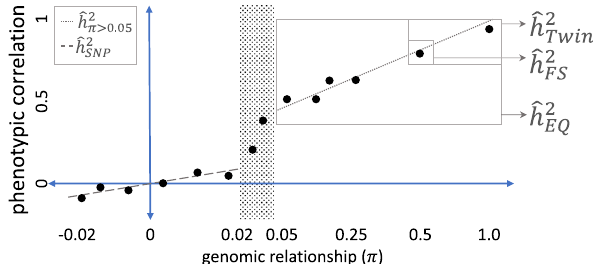
Fig. 1 Schematic of the study design. We use data from the UK Biobank to group pairs of individuals based on their genomic relationship ( π ), and calculate phenotypic correlations within 54 genomic relationship bins for 32 traits across the spectrum of relatedness. Subsets of the data are then used to estimate ^ h under different designs, where the design-dependent estimates are de fi ned in Table 1. From previous studies, we expect the slope of the regression of phenotypic correlation on genomic relationship in unrelated individuals ( π < 0 : 02) to be less than that observed in close